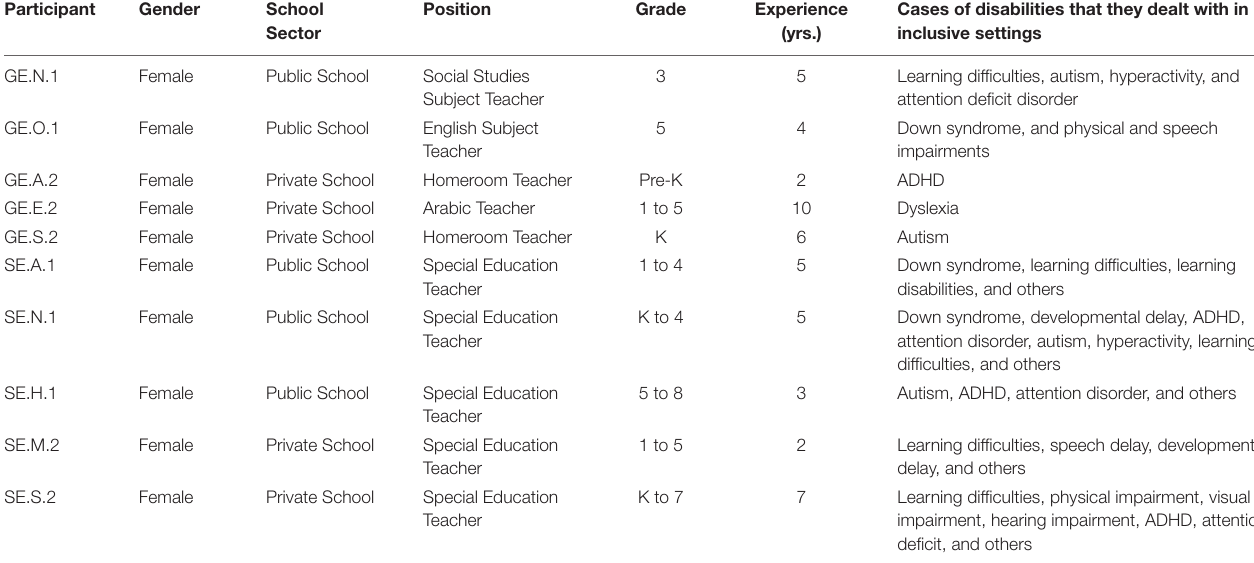
TABLE 1 | Information about